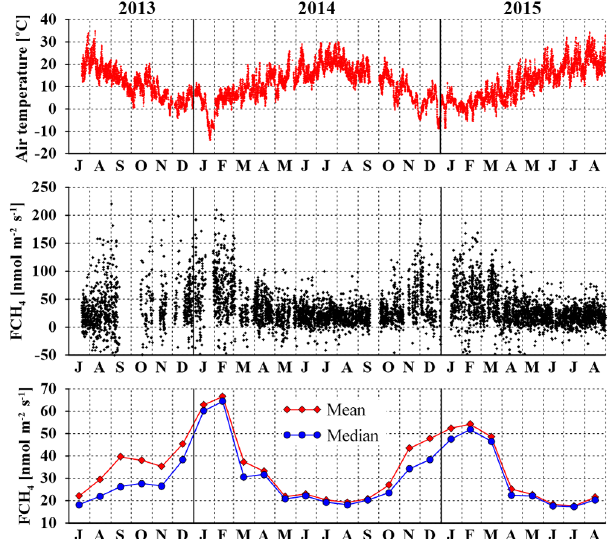
Figure 3. One-hour means of air temperature, 1h net turbulent FCH 4 flux (approved by three stationarity tests), and mean and me- dian of FCH 4 measured in the period July 2013–August